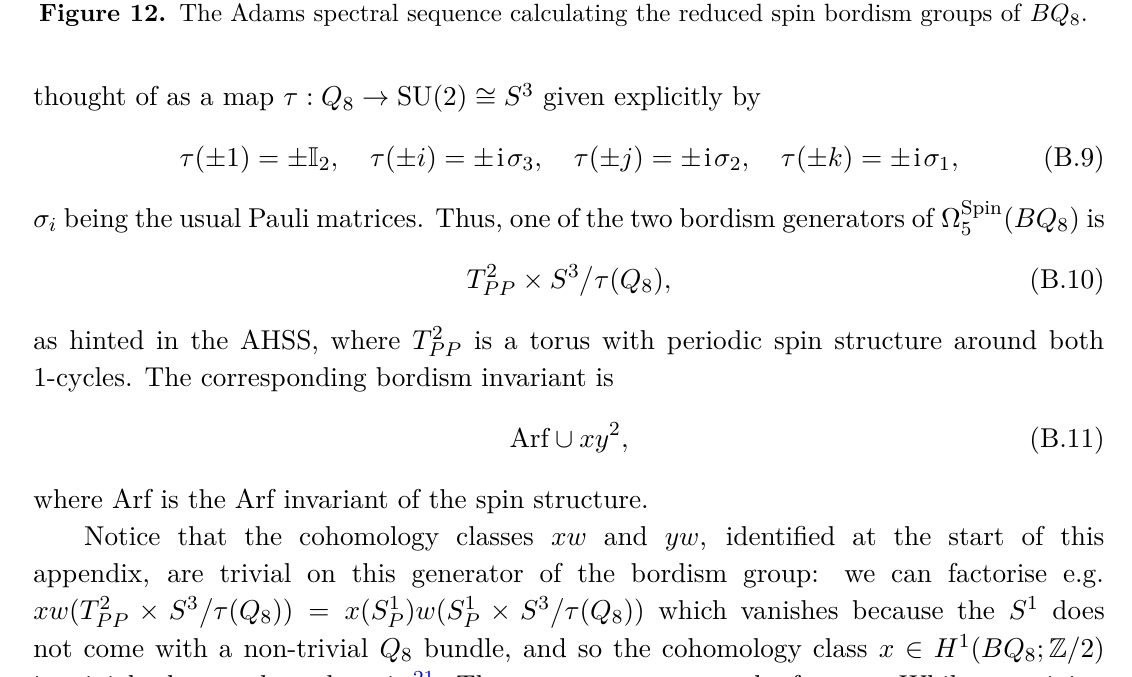
Figure 12. The Adams spectral sequence calculating the reduced spin bordism groups of BQ 8